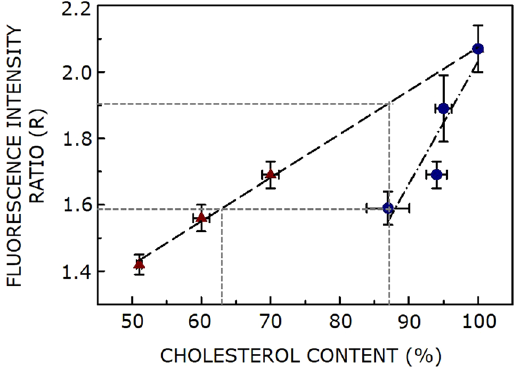
Figure 4. Differential dependence of membrane dipole potential on membrane cholesterol content under acute and chronic depletion conditions. A plot of R (a measure of membrane dipole potential, values taken from Figs 2c and 3c) with membrane cholesterol content for acute (M β CD; maroon triangle) and chronic (lovastatin; blue circle) depletion of cholesterol. The cholesterol content data is from Fig. 1. Data points represent means ± S.E. and the lines shown are linear fits. An interesting feature is the difference in slope observed under acute (~0.013) and chronic (~0.037) depletion conditions, thereby indicating a stronger dependence of R on cholesterol content under chronic depletion condition. The orthogonal projections on the axes show that membrane dipole potential could vary appreciably even when membrane cholesterol content is identical . See text for more